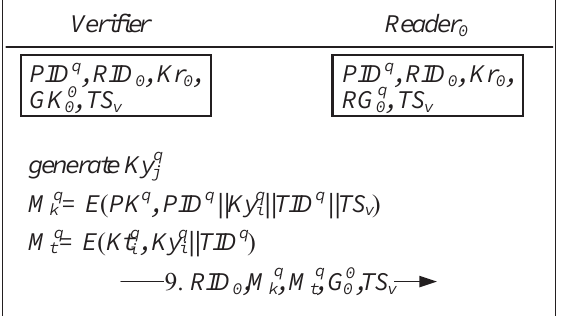
Figure 5. Acquiring the new ownership of shared keys from the verifier.